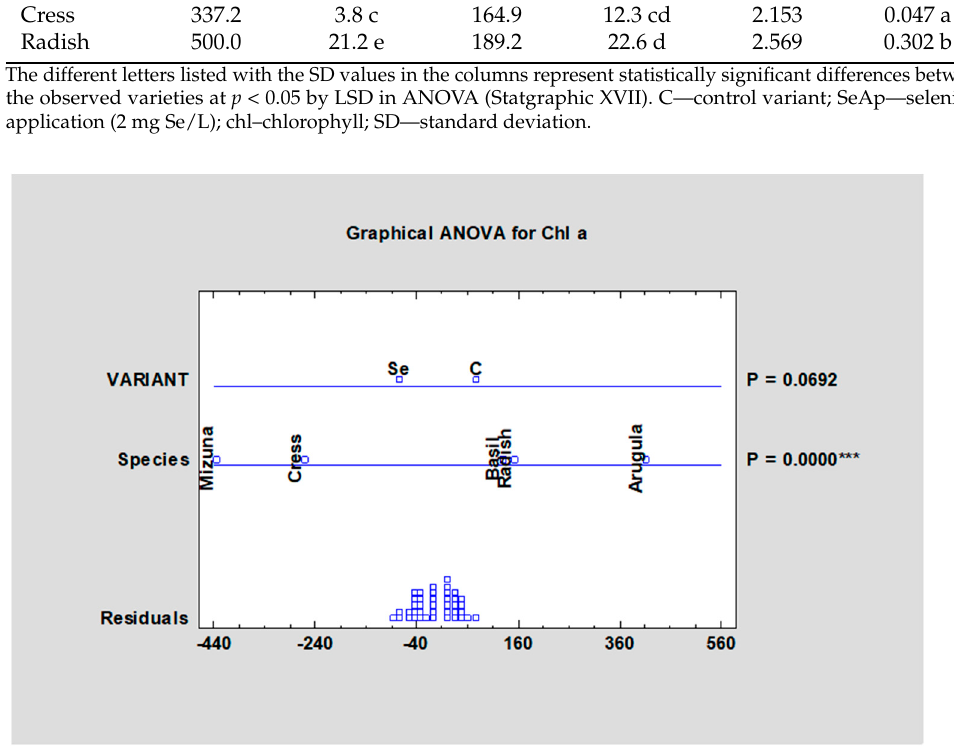
Figure 3. Chlorophyll a content in microgreens species after fortification with sodium selenate. Fw — fresh weight, control; SeAp — selenium application (2 mg Se/L), *** statistically